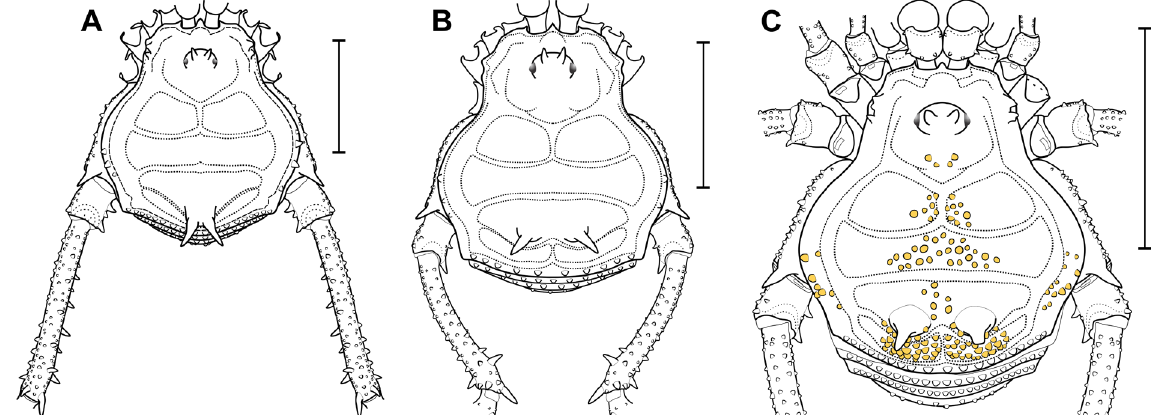
Fig. 9. Lacronia spp., female specimens, dorsal habitus. A . L. boraceae (B. Soares, 1942) comb. nov., holotype (MZSP 114 ꜝ ), schematic illustration. B . L. nigra (Mello-Leitão, 1923) comb. nov., holotype of Discocyrtus fazi Piza, 1942 (MZSP 1549 ꜝ ), schematic illustration. C . L. serripes Mello-Leitão, 1923 (MZSP 9973). Scale bars = 3